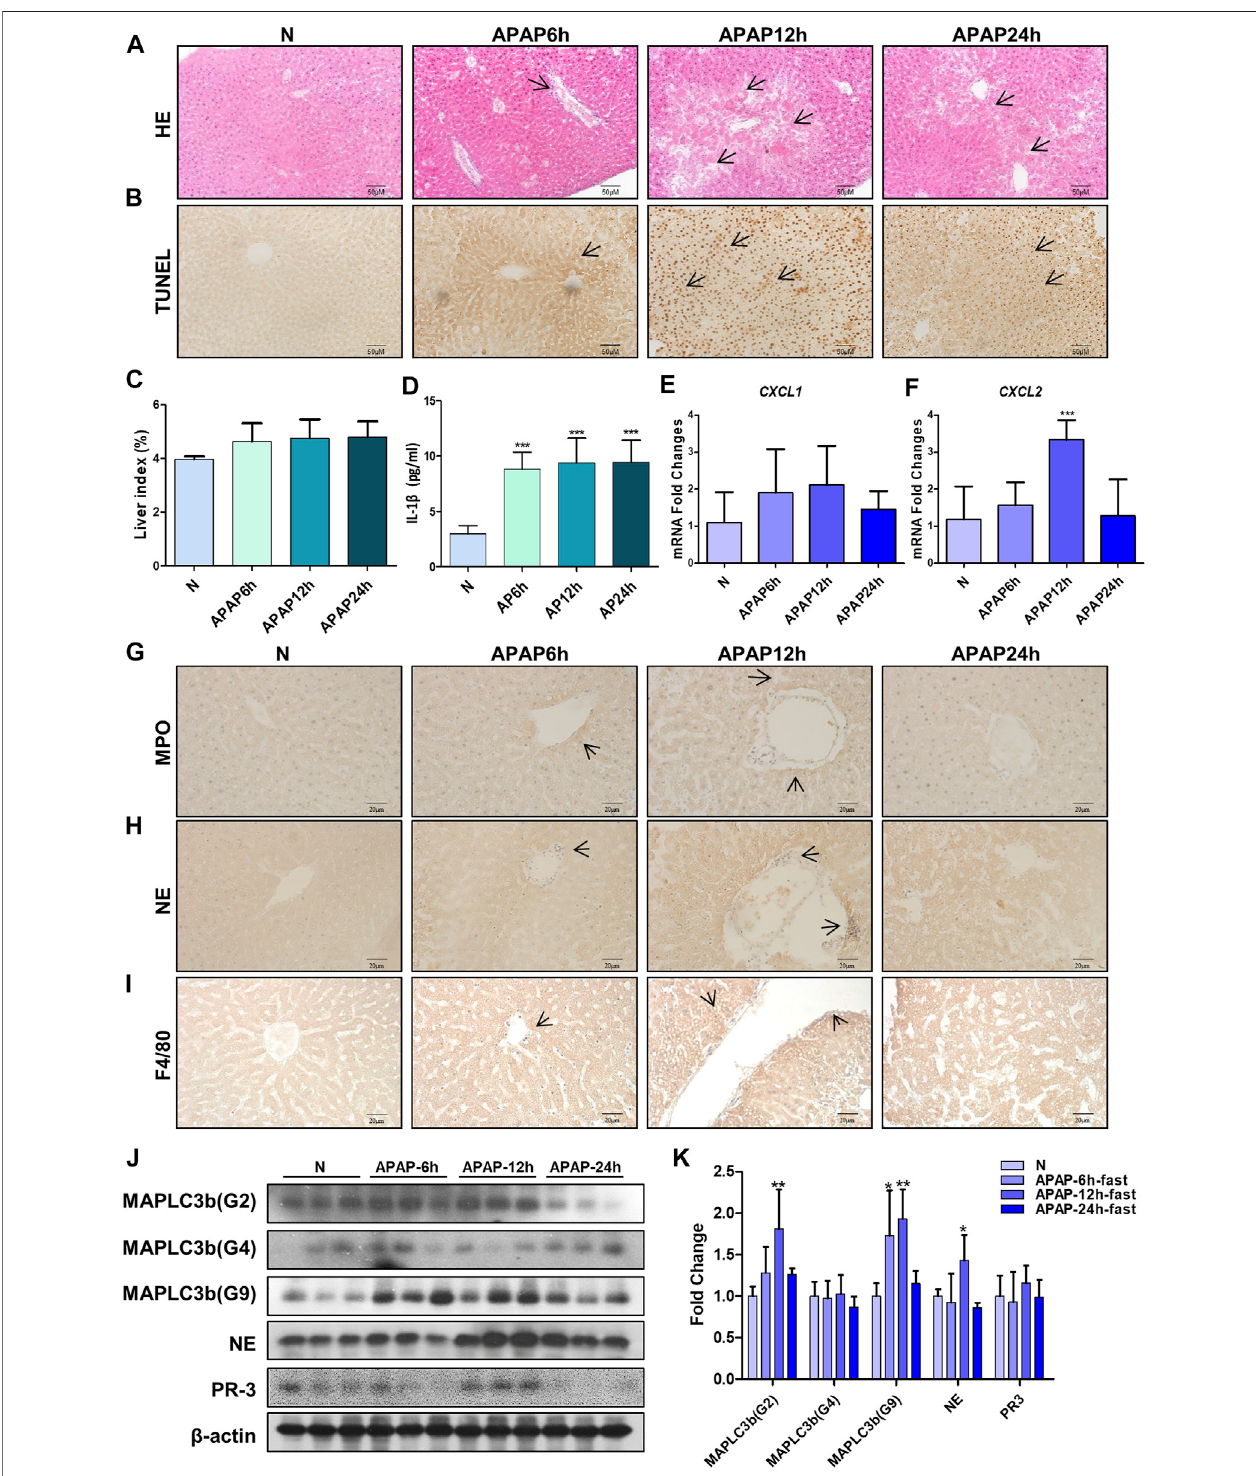
FIGURE 5 | Evaluation of liver injury induced by different time gradients of APAP under fasting condition and the expression ofchemokines and autophagy-related proteinsinthe invivo modelofAPAPliverinjury.C57BL/6micewererandomlydividedintonormalgroups,APAP(300 mg/kg)6,12and24 hgroups.Fastingbegan12 h beforeAPAP wasgiven. (A,B) HE and TUNEL staining, the image ismagni fi ed200 × . Speci fi cstainingindicatedby arrow. (C) Liverweight index. (D) Expression ofIL-1 β in serum. (E,F) Real-time quantitative PCR results of chemokine CXCL-1 and CXCL-2. (G – I) Immunochemical staining of MPO, NE and F4/80, the image is magni fi ed 400 × . (J,K) MAPLC3 β (Gmur2), MAPLC3 β (Gmur4), MAPLC3 β (Gmur9), NE and PR3 protein expression and gray-scale density analysis relative to β -actin. * p < 0.05, ** p < 0.01, *** p < 0.001,signi fi cantly differentfrom thenormalgroup. One-wayANOVA followed byTukey ’ stest. Thedata areexpressed asthe mean ± SDof fi ve independent assays with at least three